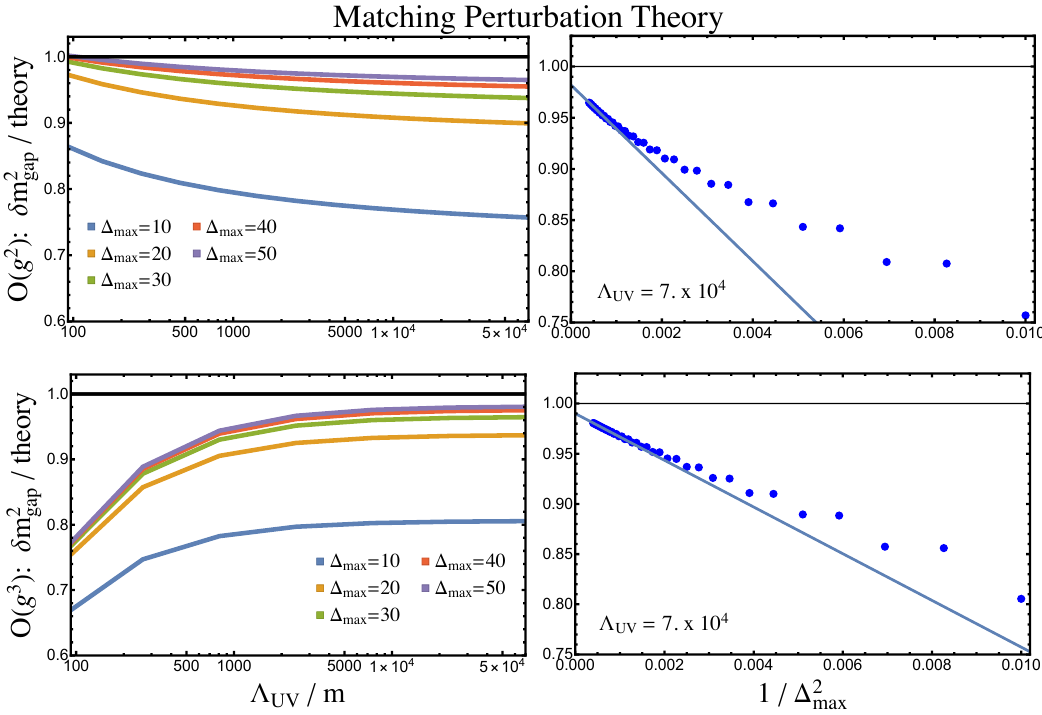
Figure 6 . Top row: perturbative, UV-divergent 1-particle mass shift at O ( g 2 ) , computed before adding any counterterms. Bottom row: perturbative, UV-finite 1-particle mass shift at O ( g 3 ) . In all four plots, Λ = 0 . 5 and r = 0 . 8 IR /m